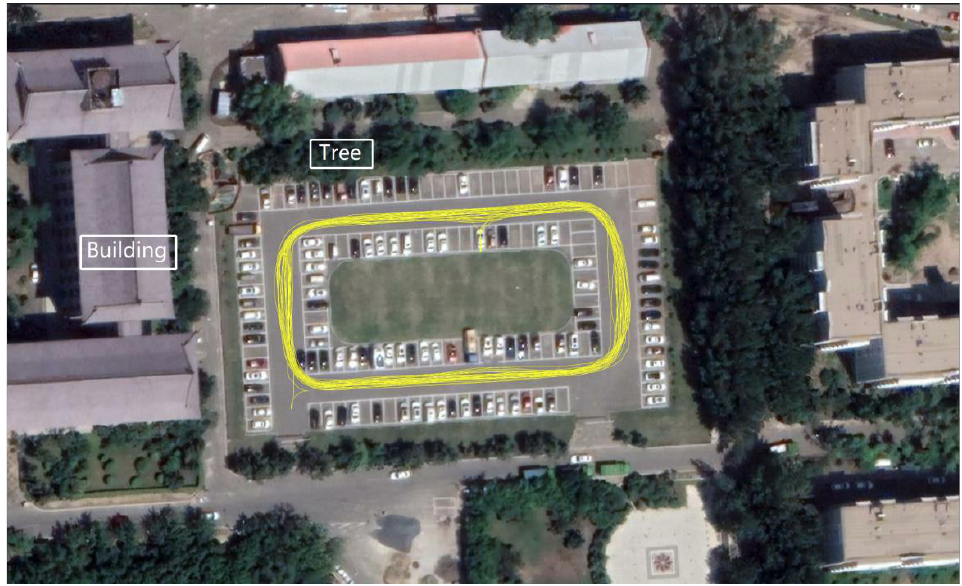
Figure 8. The motion trajectory of